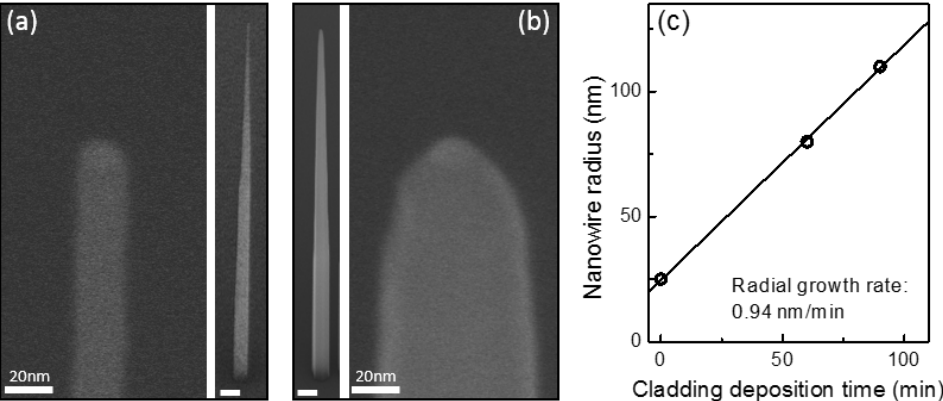
Figure 5. ( a ) SEM image of full structure (right panel) and close-up of tip (left panel) of a nanowire clad using a PH 3 flow rate of 9sccm. ( b ) SEM image of full structure (left panel) and close-up of tip (right panel) of a nanowire with a first cladding as in ( a ) plus a second cladding using a PH 3 flow rate of 15sccm. Scale bars in images of the full structure are 300 nm. ( c ) Nanowire radius as a function of the growth time used for the second